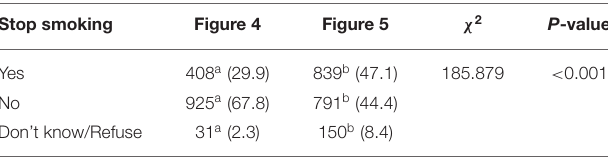
TABLE 5 | Comparison of two types of pictures on cigarette packets to stop smoking. Stop smoking Figure 4 Figure 5 χ 2 P